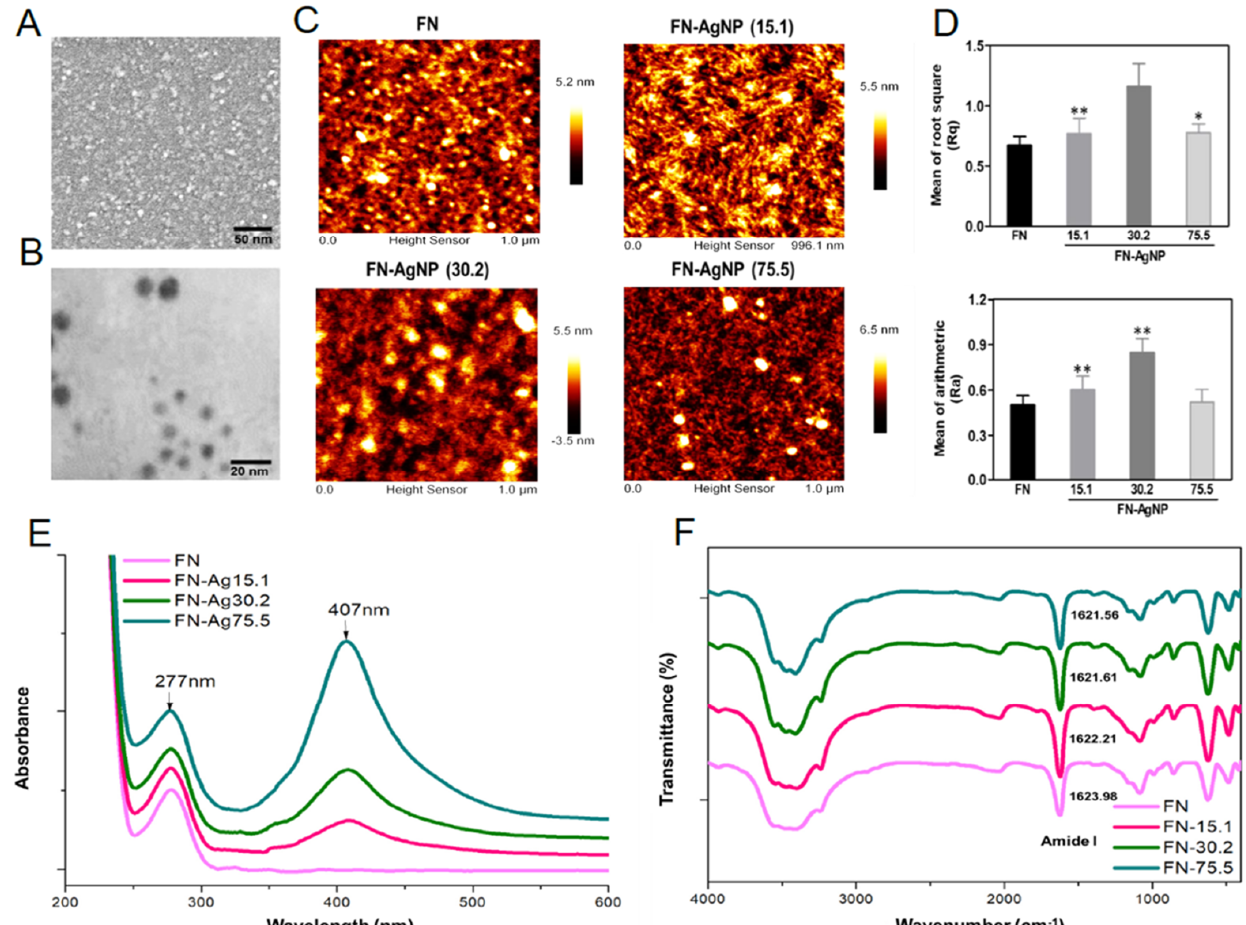
Figure 1. Materials characterization. The preparation procedure of fibronectin-silver nanoparticle (FN-Ag) composites. ( A ) SEM images of AgNP and ( B ) TEM image of the diameter of AgNP was about 5 nm. ( C ) Preparation of FN-AgNP nanocomposites. The surface topography of pure FN and FN-AgNP containing various amount of Ag were observed by AFM. ( D ) Rq is the roughness, while Ra represents as the average roughness of each material. * p < 0.05, ** p < 0.01: greater than the control (FN). ( E ) UV-Visible absorption peak of pure FN and FN-Ag containing various amount of AgNP (~15.1 ppm, ~30.2 ppm and ~75.5 ppm). ( F ) FTIR spectrum of pure FN and FN-Ag nanocomposites in the total wave number 400 cm −1 to 4000 cm −1 . Data results from one representative experiment of three independent experiments.